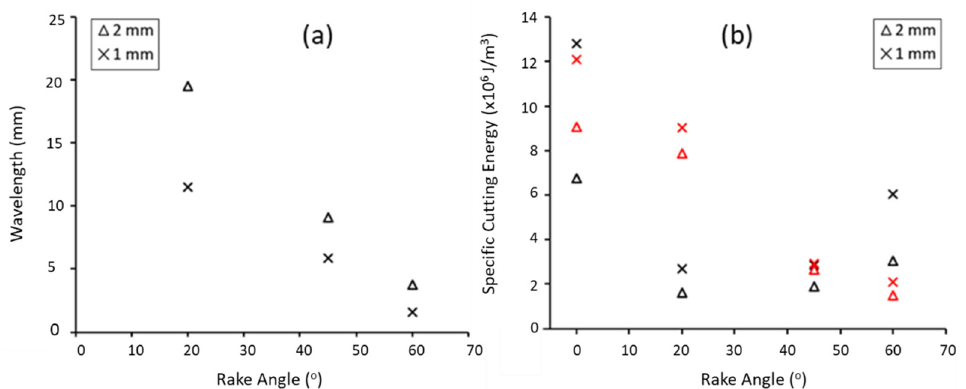
Figure 7. ( a ) Average wavelengths for discontinuous chip formation, determined from the experi- mental force curves in Figure 6. ( b ) Specific cutting energy as a function of rake angle (black markers, experimental results; red markers, CFI model results).